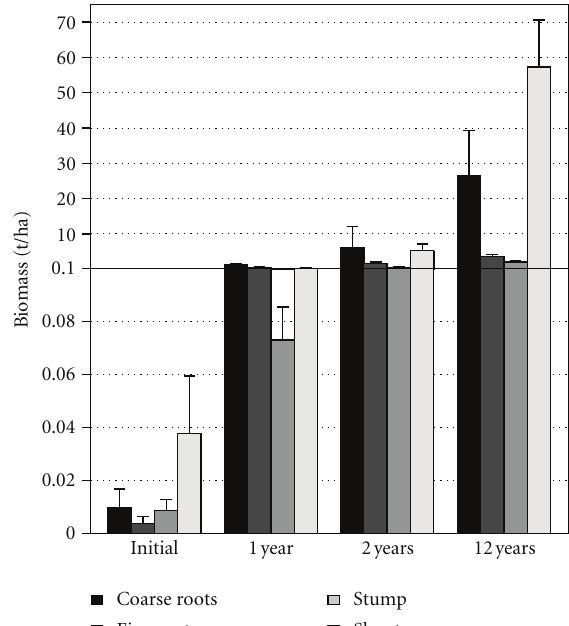
Figure 2: Absolute dry matter distribution of the woody biomass compartments shoot , stump , fine roots and coarse roots , for seedlings (Initial), a one-, two- and a twelve-year-old stand of Robinia pseudoacacia (standard deviation is plotted as error bar).